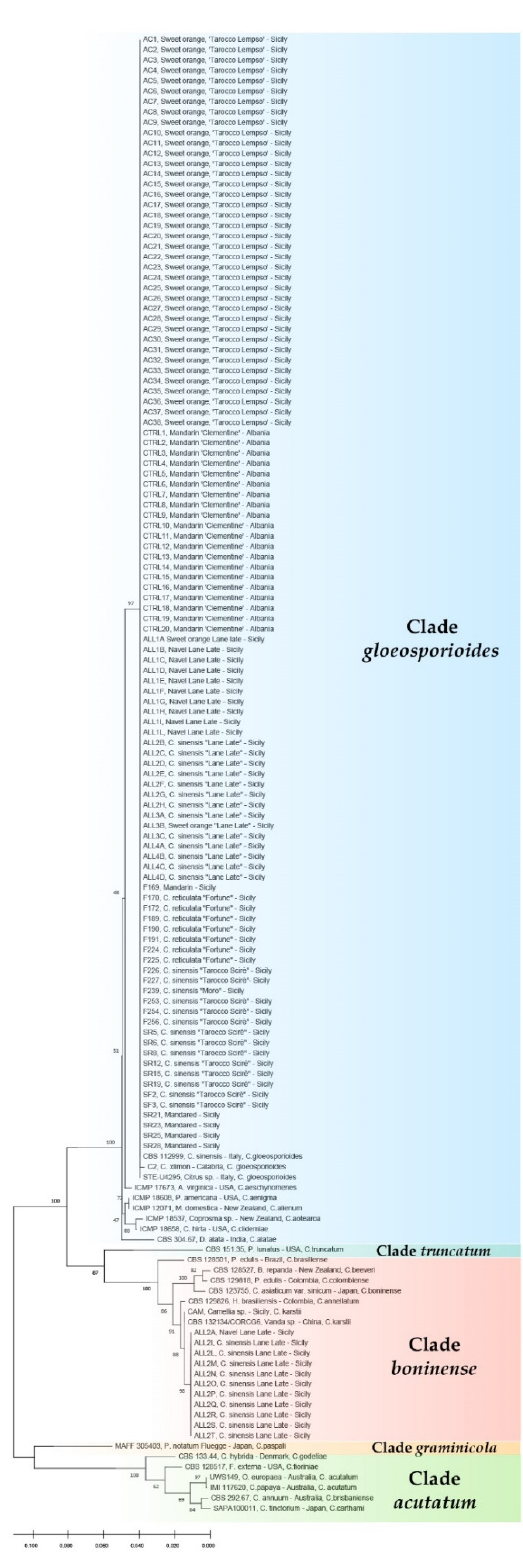
Figure 3. Phylogenetic tree obtained using combined internal transcribed spacers (ITS) and β -tubulin (TUB2) sequences of isolates of Colletotrichum spp. collected in the present study along with reference isolates of C. karstii , C. gloeospoiroides , and other representative species of the other